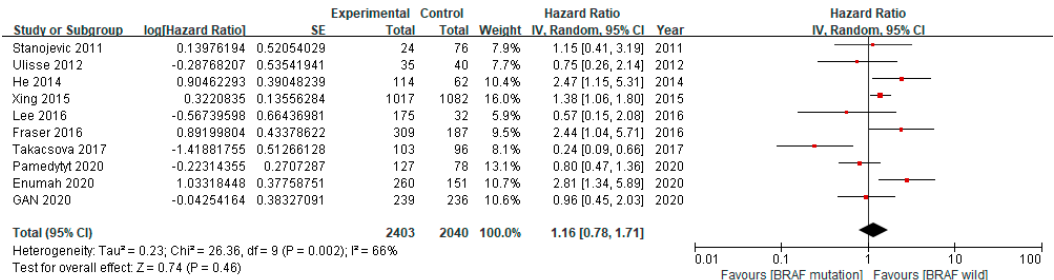
Figure 3. Forest plot of the included studies analyzing the adjusted recurrence rates between the patients with the BRAF V600E mutation and those with wild-type BRAF.